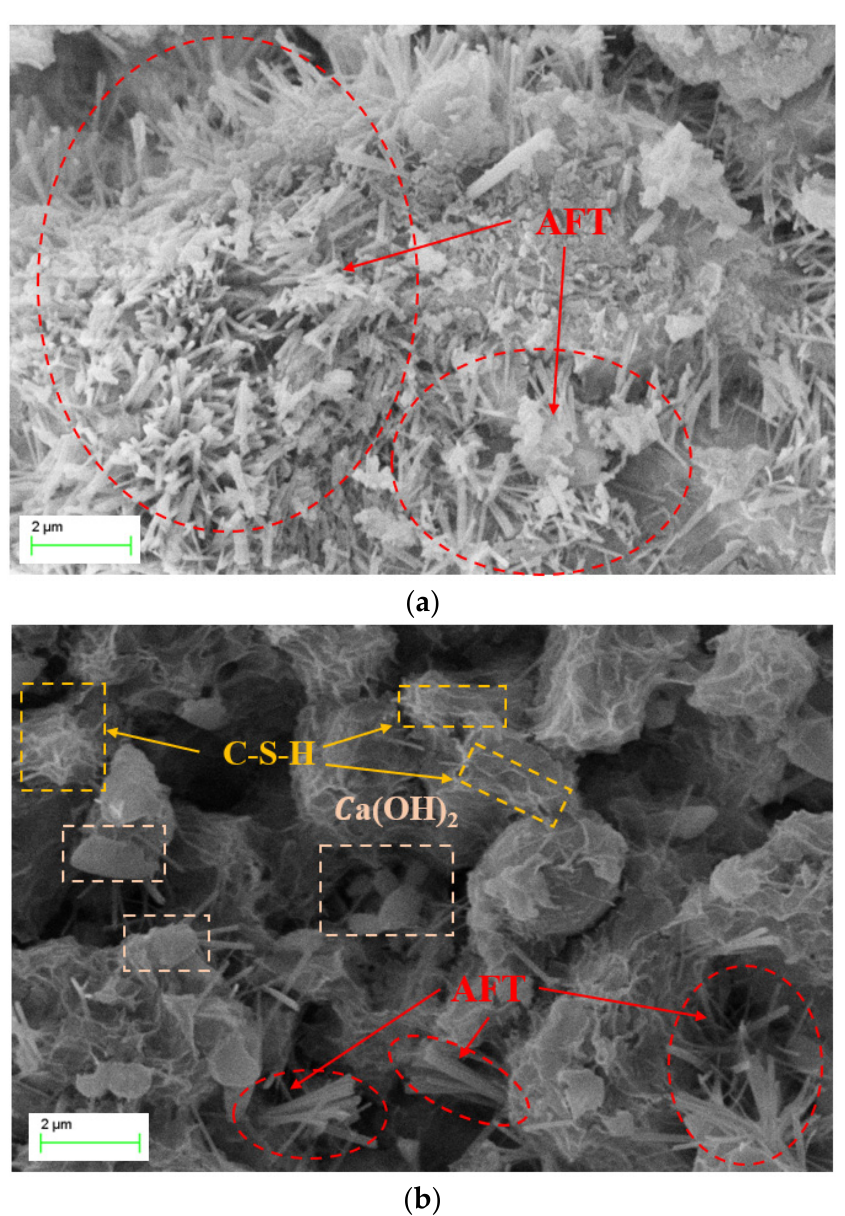
Figure 12. ITZ (gangue) SEM experimental results (Group 3). ( a ) ITZ (gangue) scan results 1. ( b ) ITZ (gangue) scan results 2.